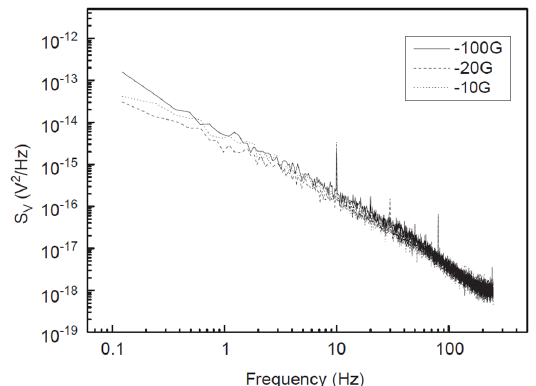
Figure 5. 1/ f noise in a yoke-type GMR with sensitivity of 0.4 nT/Hz 0.5 for different external applied fields [63].